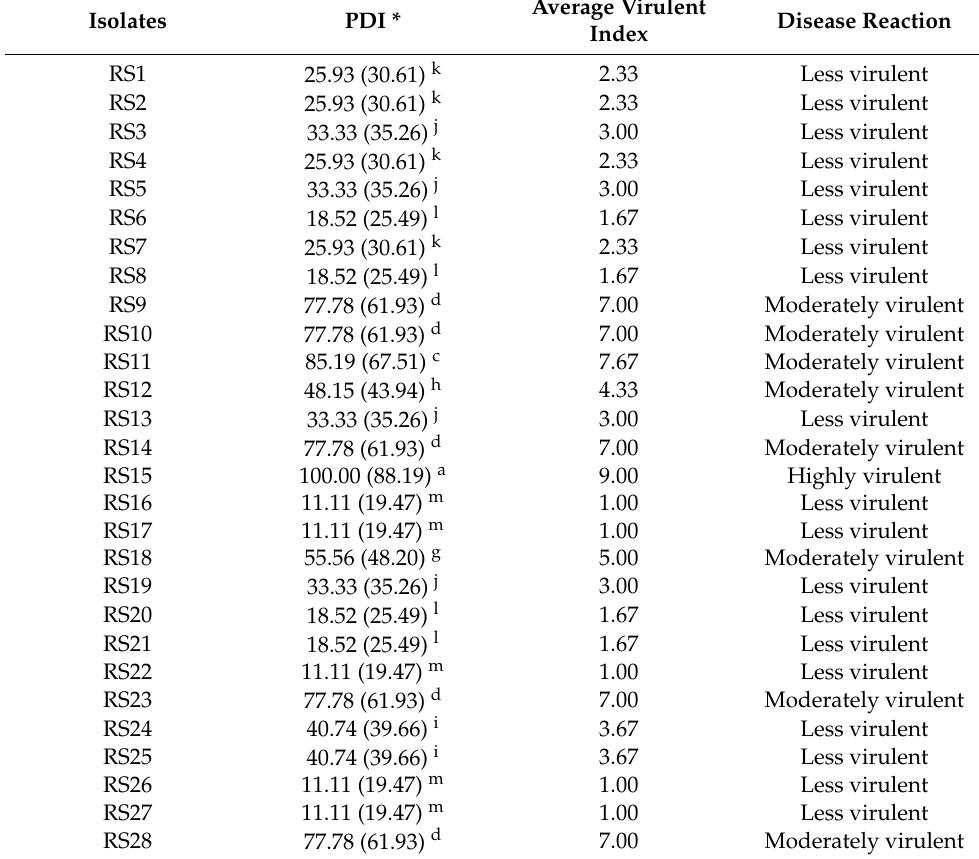
Table 1. Pathogenicity of R. solani isolates on